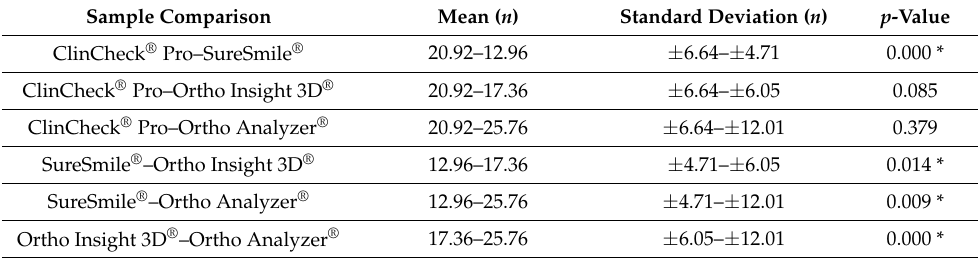
Table 4. Pairwise comparison for the number of maxillary